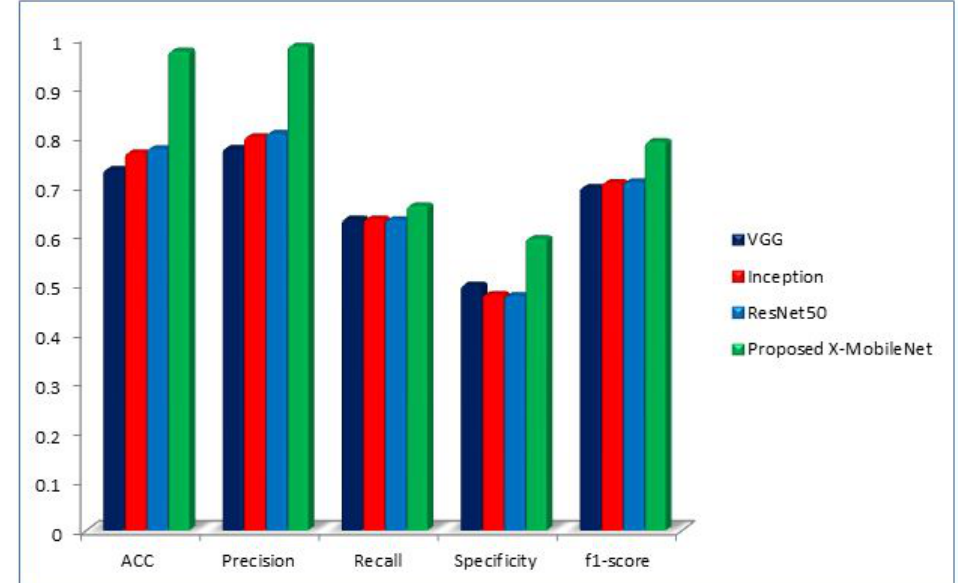
Figure 11. Performance measure comparison of proposed X-MobileNet with other existing